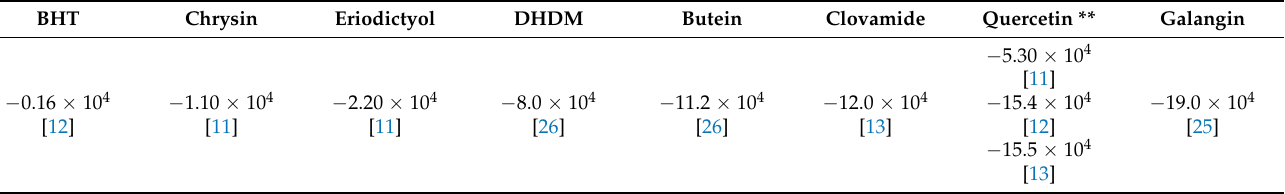
Table 1. Slopes of collection efficiency (indicators of scavenging superoxide) [11] for several poly- phenols using the RRDE method.